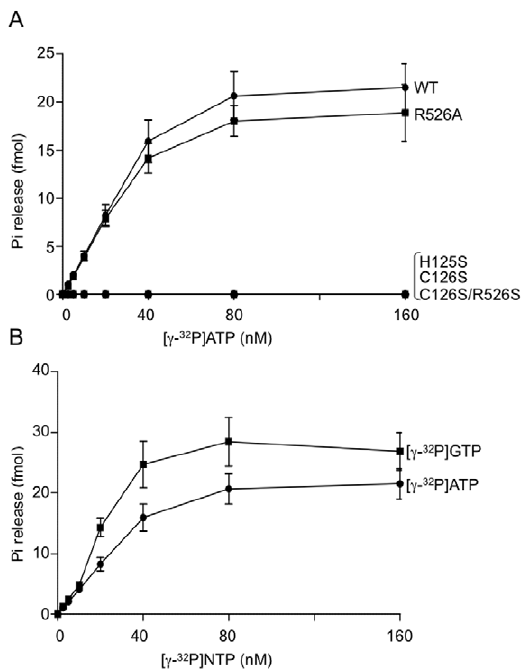
Figure 3. Triphosphatase activity of recombinant TvCE. A. Enzymatic activity of wild-type (WT) (filled circle) and mutants [R526A (filled square), H125S (filled triangle), C126S (open triangleD), C126S/ R526S (open square)] was compared across a range of [ c - 32 P]ATP concentration. B. Enzymatic activity of wild-type TvCE was measured across a range of [ c - 32 P]ATP (filled circle) and [ c - 32 P]GTP (filled square) concentration for comparison of relative substrate affinity. Products were resolved on TLC plates and quantified by liquid scintillation counting.